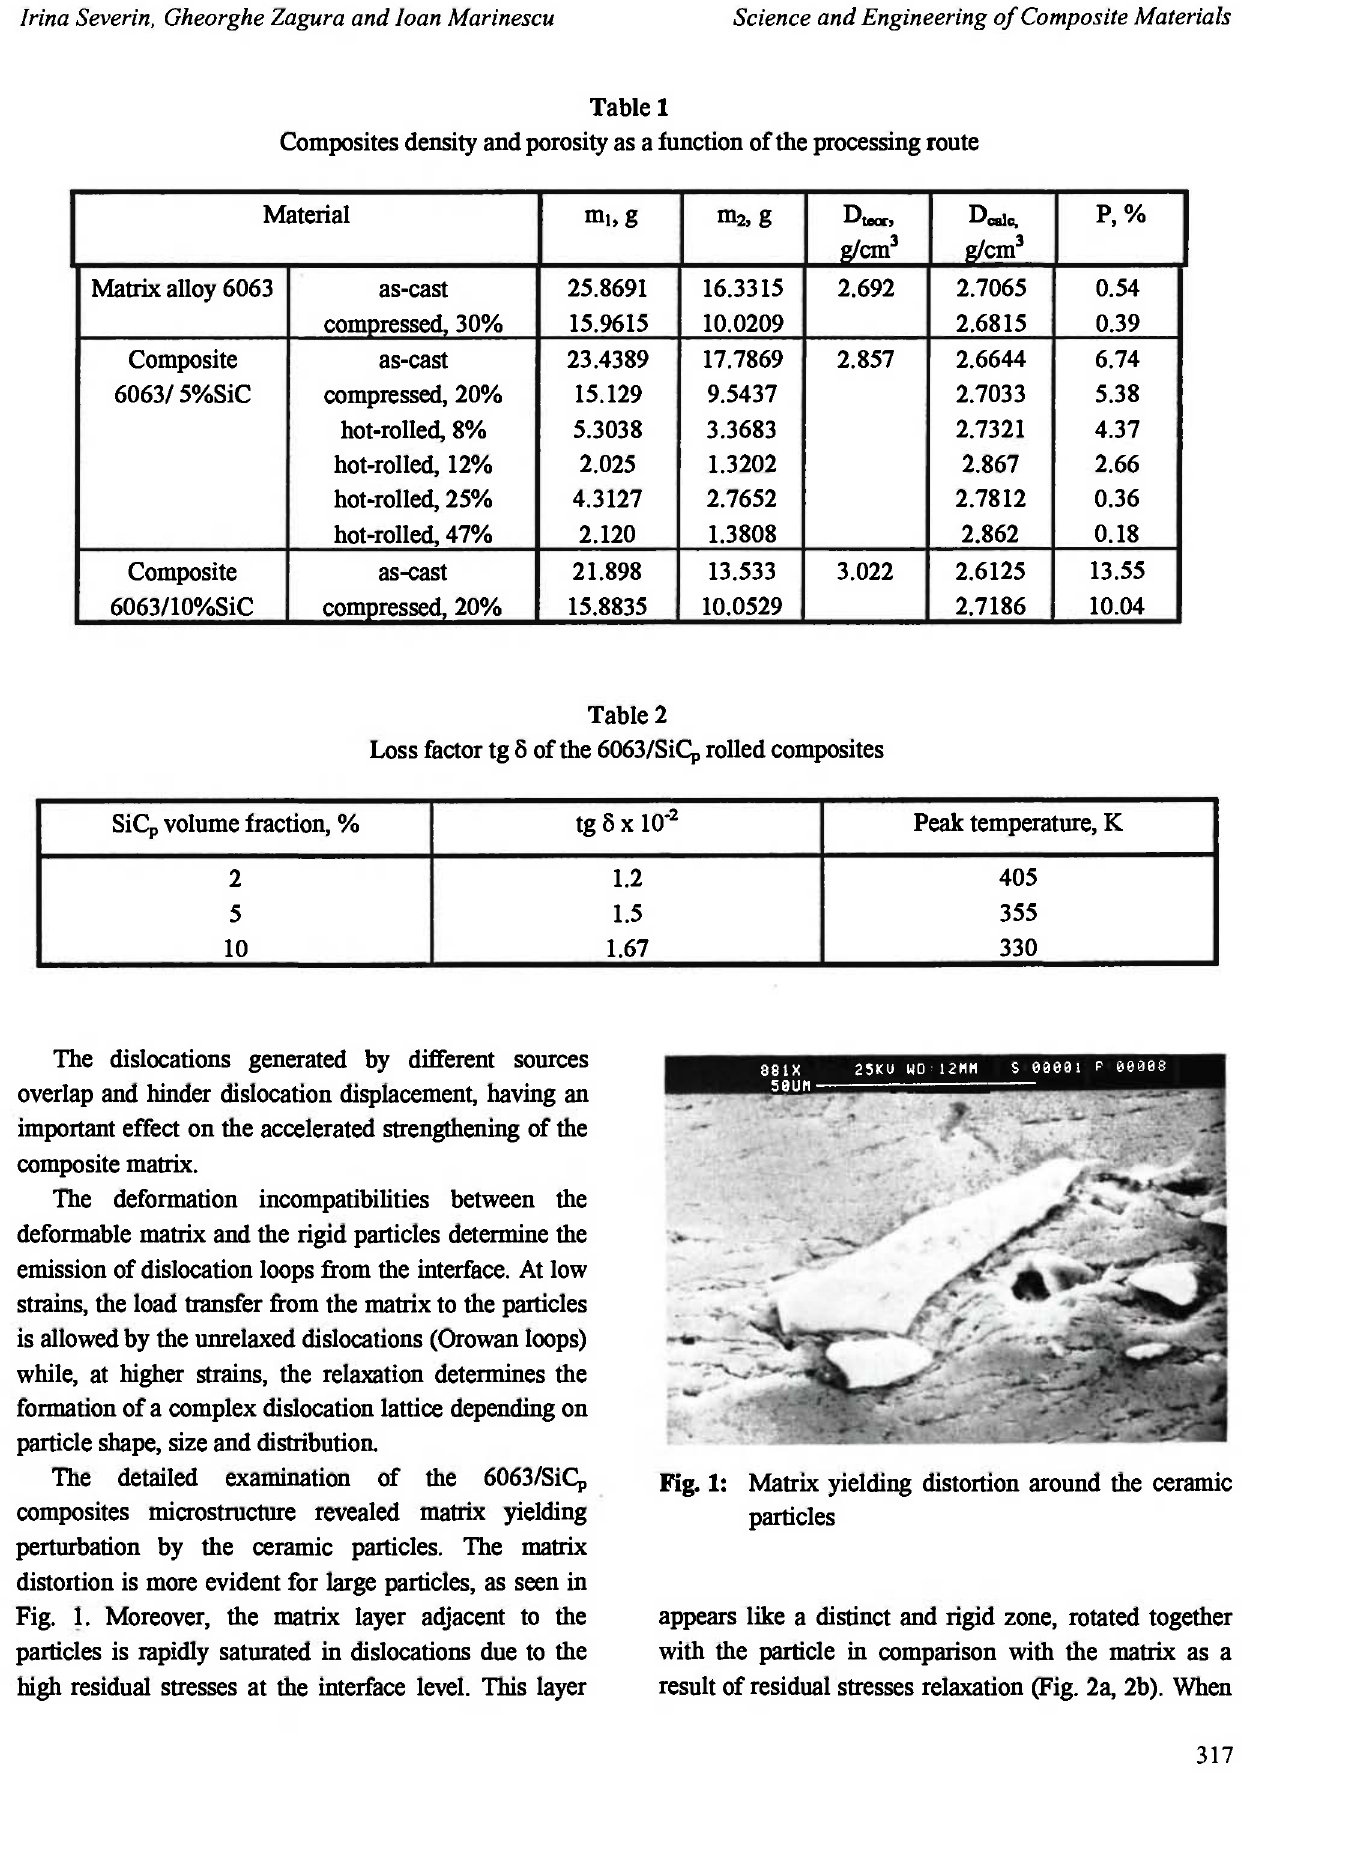
Composites density and porosity as a function of the processing route Material